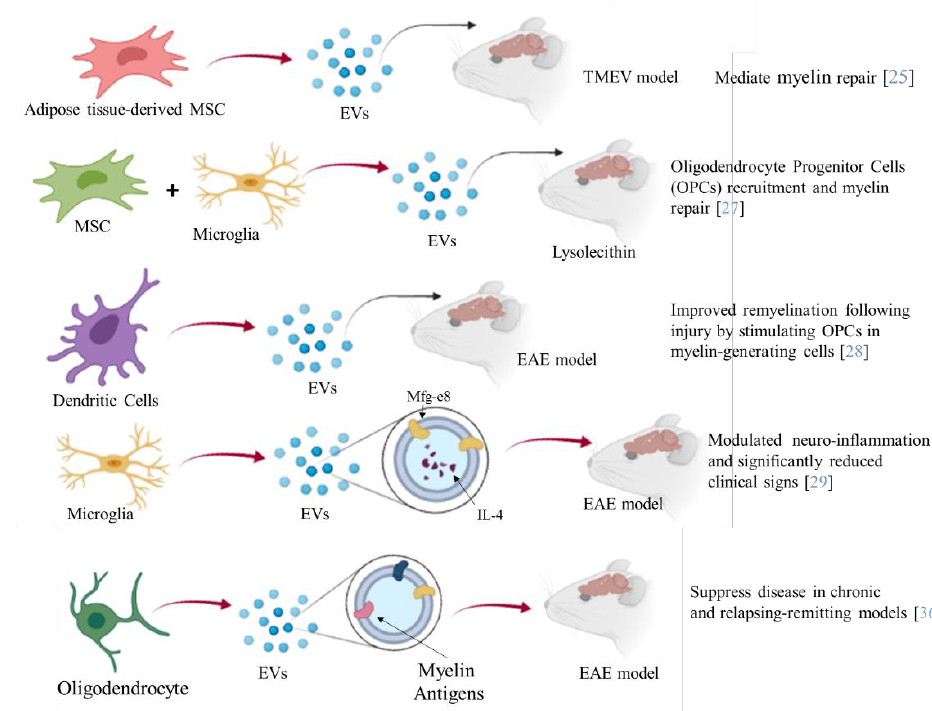
Figure 2. The picture summarizes the different aspects of the therapeutic potential of EVs in MS. EVs released from different cells, engineered or not, have been administered to different mouse models of MS. A reduction of the demyelination area, inflammation degree, and severity of MS symptoms have been observed.